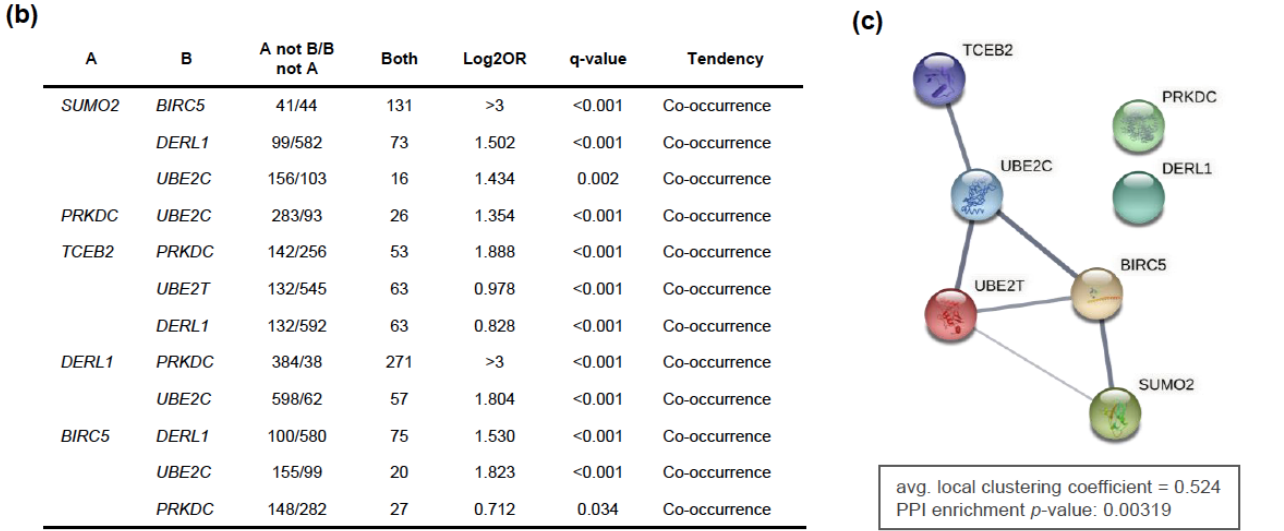
Figure 4. Association between gene expression and a worse relapse-free survival in breast cancer patients. ( a ) Survival analysis for individual genes correlated with poor relapse-free survival among the frequently amplified genes. ( b ) Co- occurrence of mutations in the analyzed population calculated by the odds ratio method. ( c ) Protein-protein interaction map displaying the significant functional network integrated by the selected genes. Line thickness denotes the strength of the association.